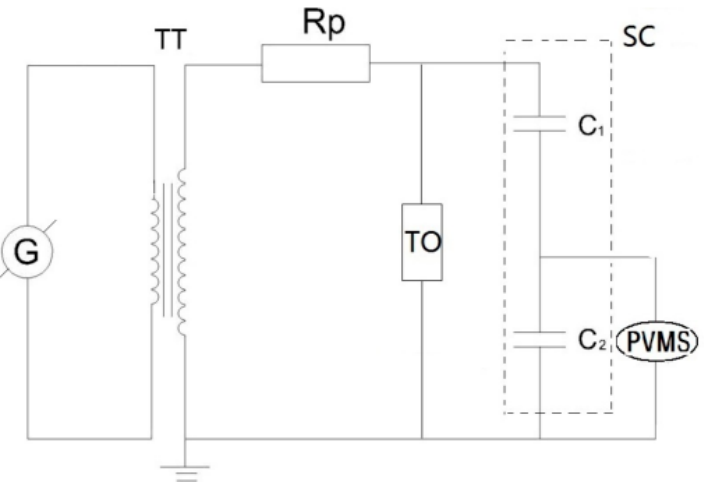
Figure 11. Power frequency resistance voltage test. TT: testing transformer; G : generator; R p : protec- tion resistance; TO: test object; C 1 / C 2 :H.V/L.V arm-capacitance; R : damping resistance; PVMS: power tection resistance; TO: test object; C 1 / C 2 : H.V/L.V arm-capacitance; R : damping resistance; PVMS: frequency voltage measuring system. power frequency voltage measuring system.